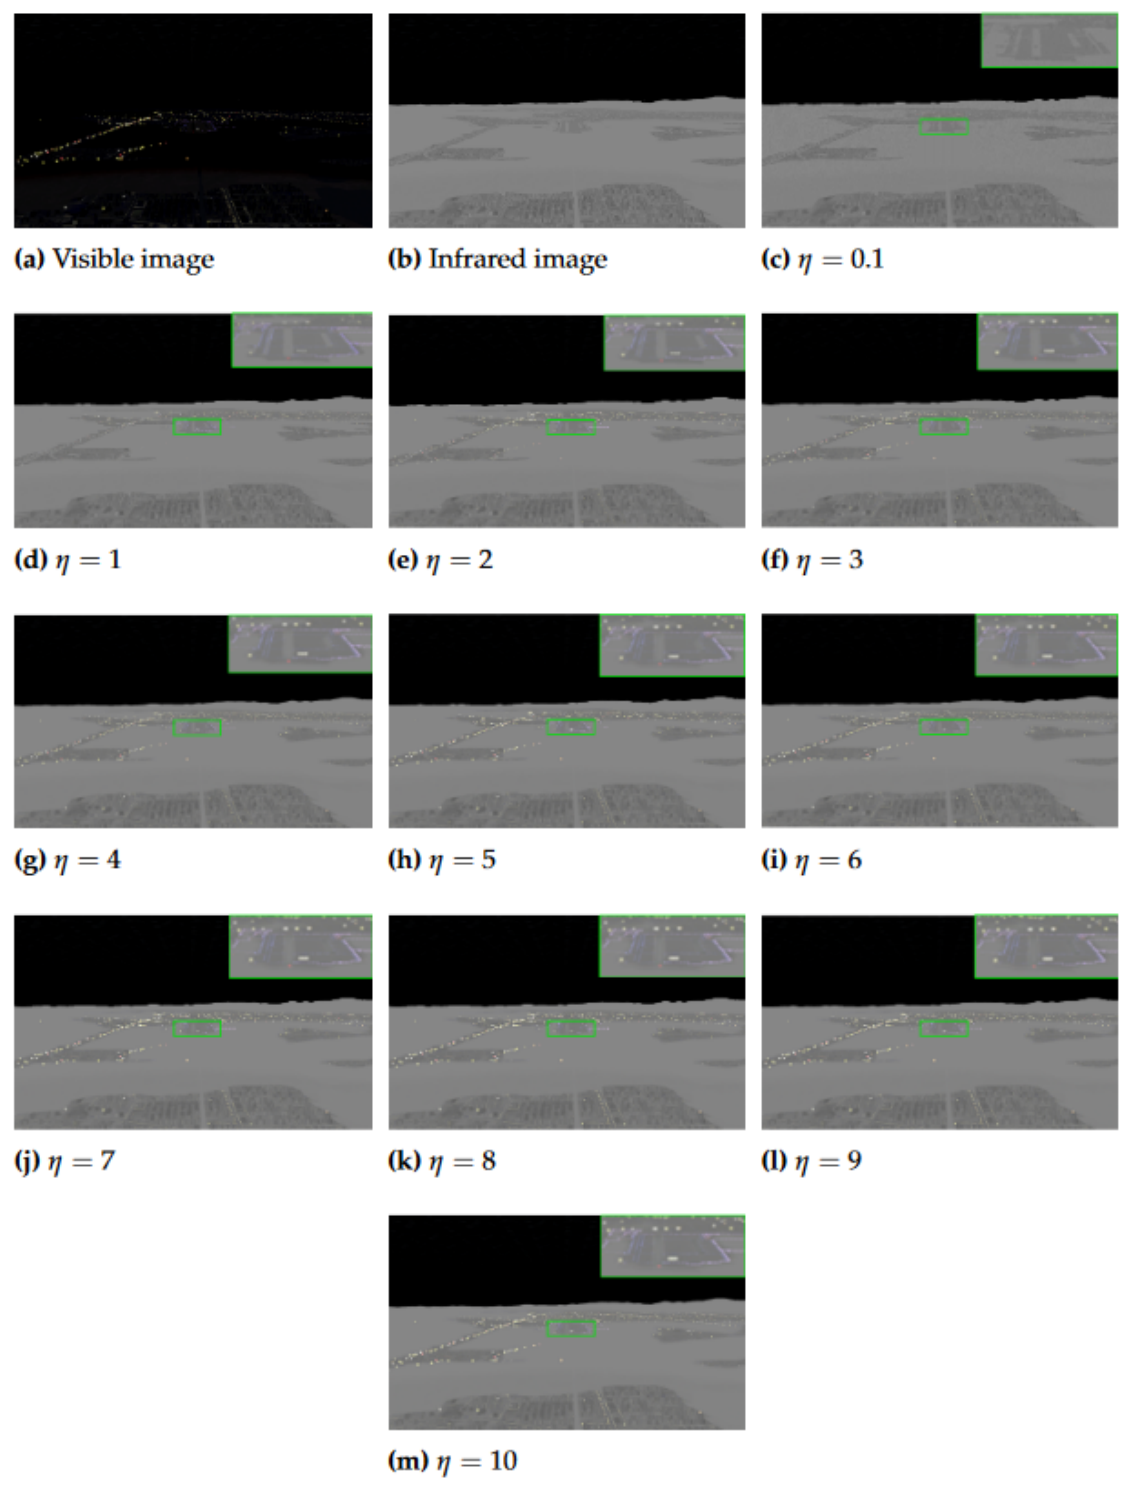
Figure 11. Fused results of Data 1 as η